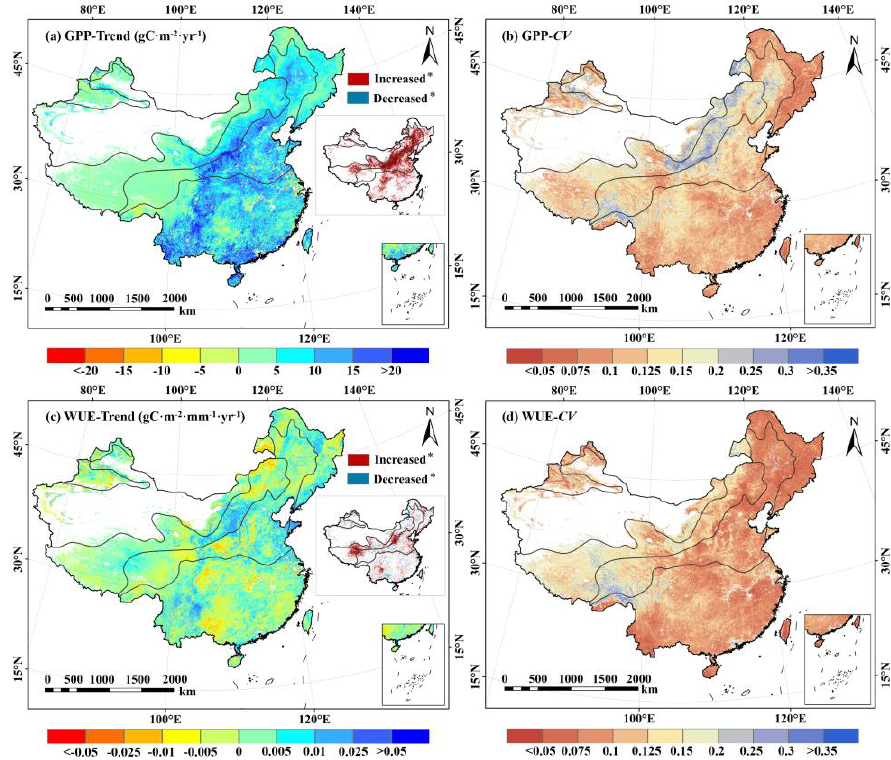
Figure 3. Spatial distribution of ( a ) GPP (units: gC · m − 2 · yr − 1 ) and ( c ) WUE (units: gC · m − 2 · mm − 1 · yr − 1 ) variation trends during 2001–2021. ( b , d ) represent spatial distribution of GPP and WUE CV . Increased* Decreased*: indicates the regions of significant increase or decrease ( p < 0.05).